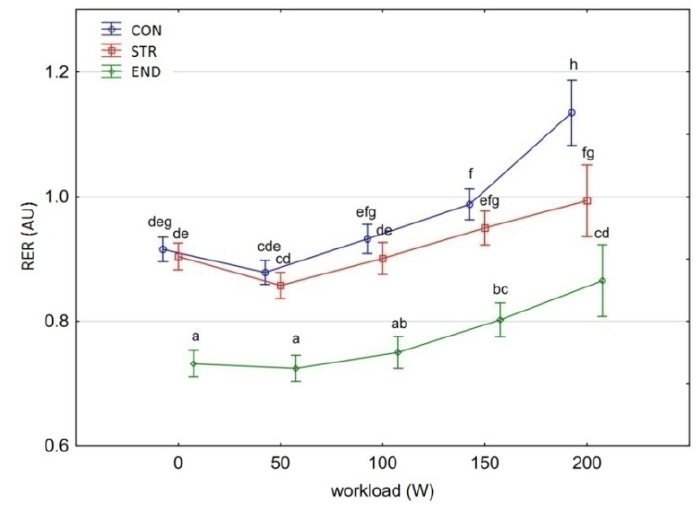
Figure 6. Respiratory exchange ratio (RER) at rest and its response during the progressive exercise test; point and whiskers—mean ± 95% CI; the signs—a, b, c, d, e, f, g, h indicate homogeneous groups ( post-hoc Tukey’s HSD test: p > 0.05).